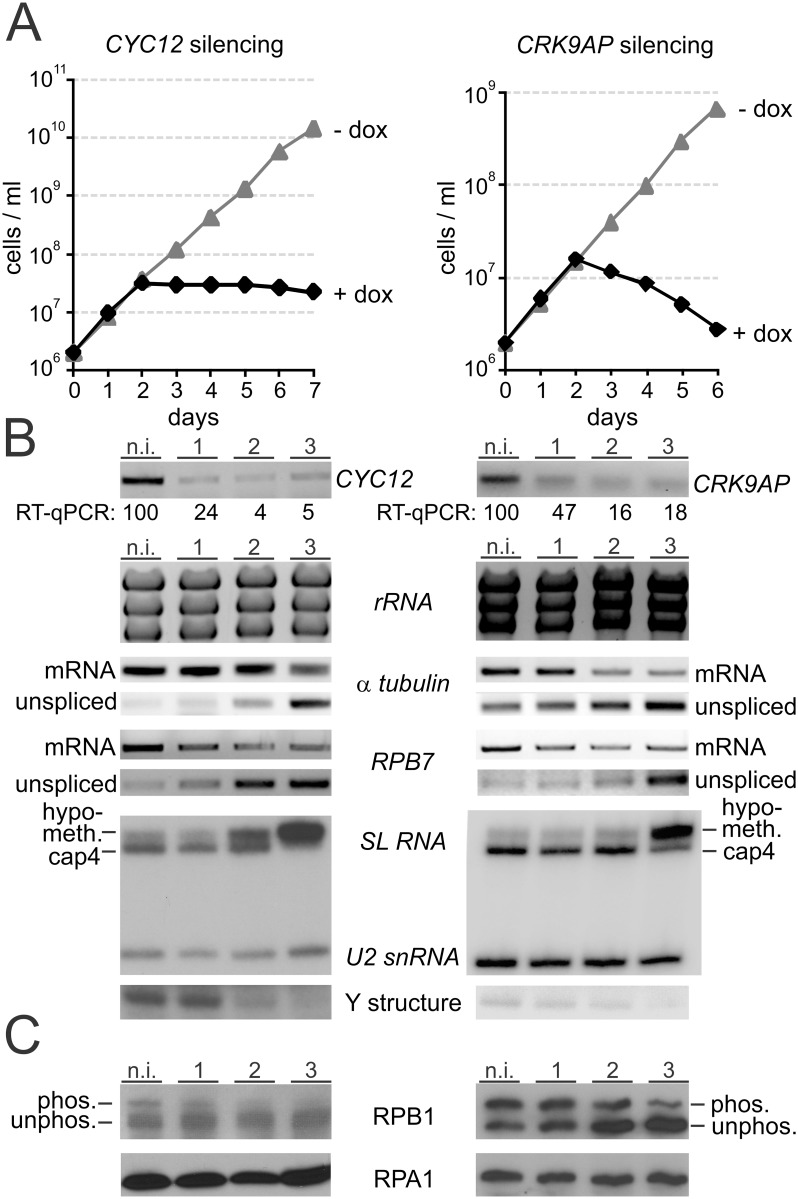
CYC12 and CRK9AP are functional partners of CRK9.(A) Cumulative culture growth curves were obtained for CYC12 and CRK9AP silencing in the absence and presence of doxycycline (dox), the gene knockdown-inducing compound. For each knockdown a representative growth curve is shown. (B) Analysis of total RNA prepared from non-induced cells and cells in which CYC12 or CRK9AP were silenced for 1, 2 or 3 days. CYC12 or CRK9AP mRNA as well as α tubulin and RPB7 mRNA were analyzed by reverse transcription of oligo-dT and semi-quantitative PCR, whereas unspliced, pre-mRNA of α tubulin and RPB7 were analyzed by reverse transcription of random hexamers and by PCR using an oligonucleotide upstream of the SL addition site. rRNA was visualized by ethidium bromide staining after separation in an agarose gel. SL RNA, U2 snRNA and the Y structure intermediate were detected by primer extension assays using a SL RNA and a U2 snRNA-specific primer in the same reactions. (C) Anti-RPB1 immunoblot analysis of whole-cell lysates prepared from CRK9AP-silenced cells. Detection of the similar-sized RNA pol I subunit RPA1 served as a loading control.